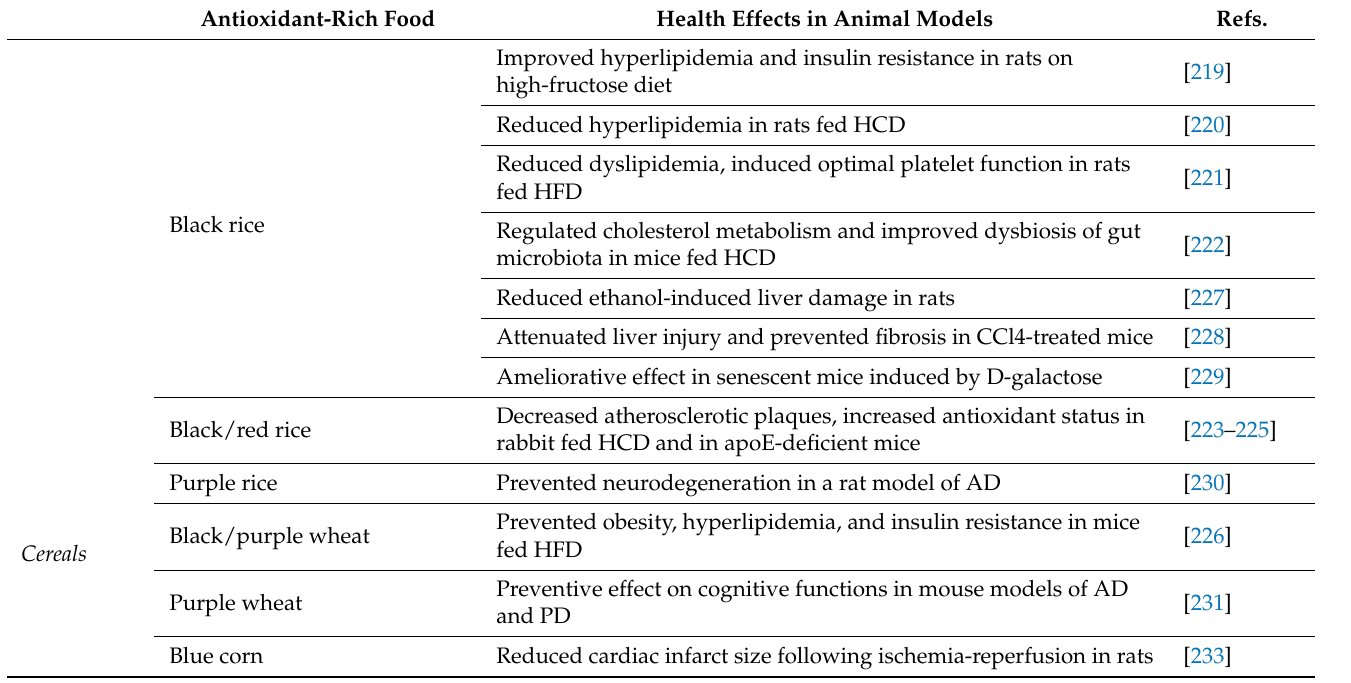
Table 4. Health effects of antioxidant-rich foods in preclinical studies. HFD, high-fat diet; HCD, high cholesterol diet; ATM, adipose tissue macrophages; Alzheimer’s disease (AD); Parkinson’s disease (PD); CCl4, carbon tetrachloride; MNU1, methyl-1-nitrosourea; GalN, D-galactosamine; and STZ,